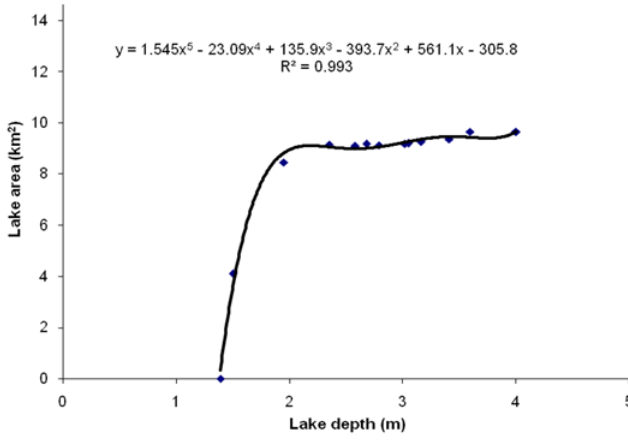
Figure 9. Relationship between lake area derived from Landsat imagery and measured lake depth.